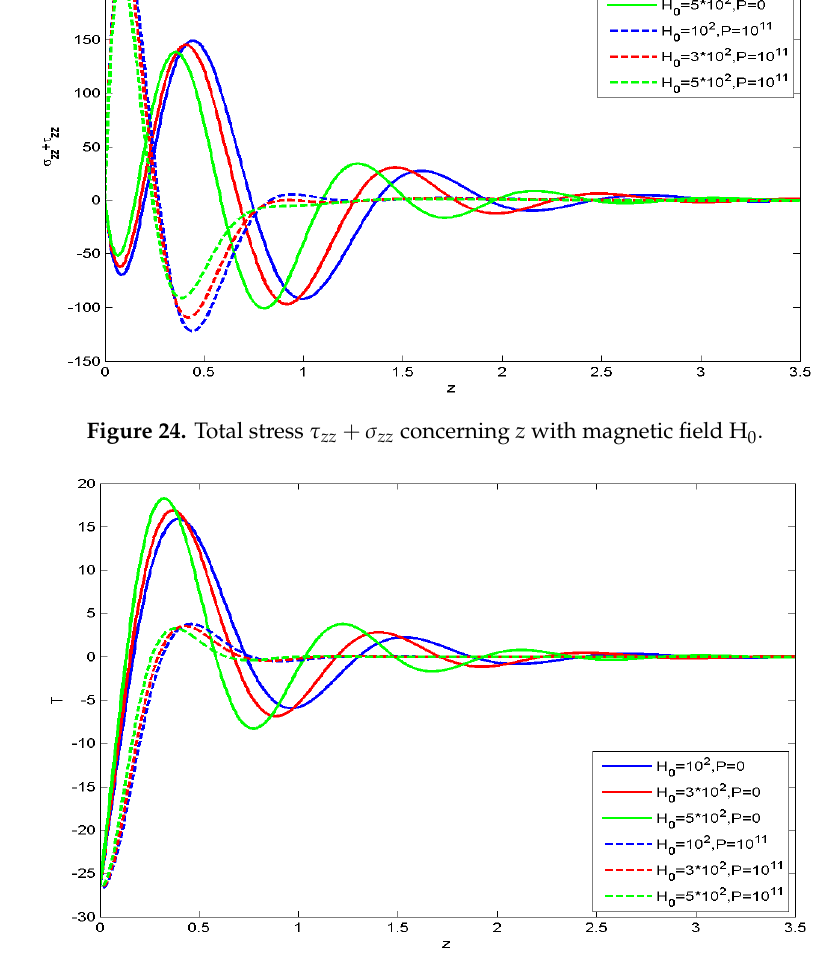
Figure 25. Temperature T concerning z with magnetic field H 0 .